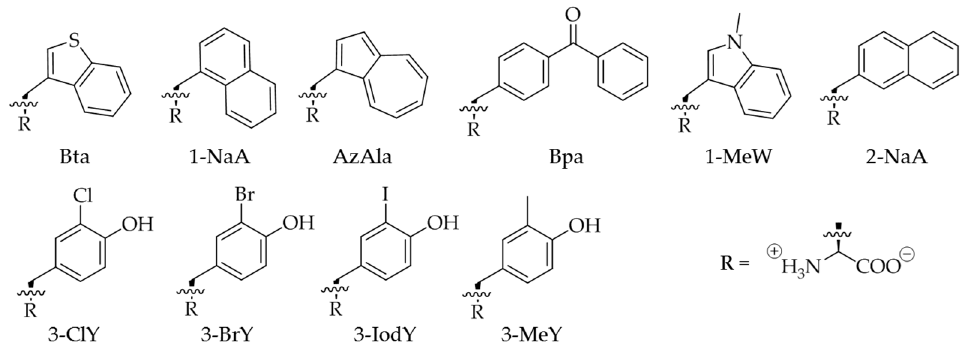
Figure 1. Chemical structure of Trp and Tyr analogs used in this study. 3-benzothienyl- L -alanine (Bta), 3-(1-naphthyl)- L -alanine (1-NaA), β -(1-azulenyl)- L -alanine (AzAla), 4-benzoyl- L -phenylalanine (Bpa), 1-methyl- L -tryptophan (1-MeW), 3-(2-naphthyl)- L -alanine (2-NaA), 3-chloro- L -tyrosine (3-ClY), 3-bromo- L -tyrosine (3-BrY), 3-iodo- L -tyrosine (3-IodY), and 3-methyl- L -tyrosine (3-MeY).